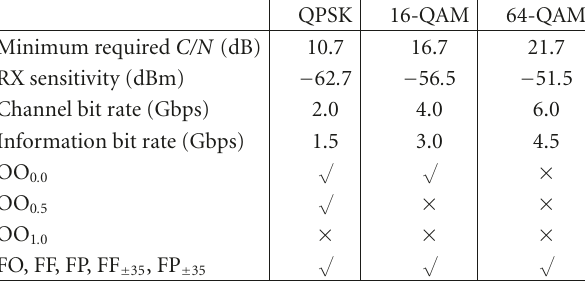
Table 5: The required C/N and RX sensitivity for the 3 / 4 coded OFDM system with guard interval 1 / 4; the feasibility of modulation schemes for various configurations at a distance d = 6 meter in the √ : yes; × : no). LOS environments (